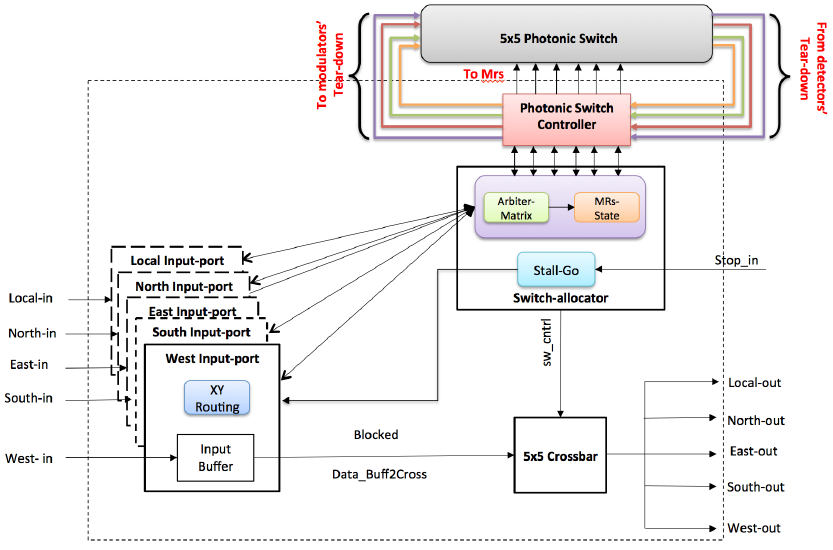
Figure 4. Light-weight electronic control